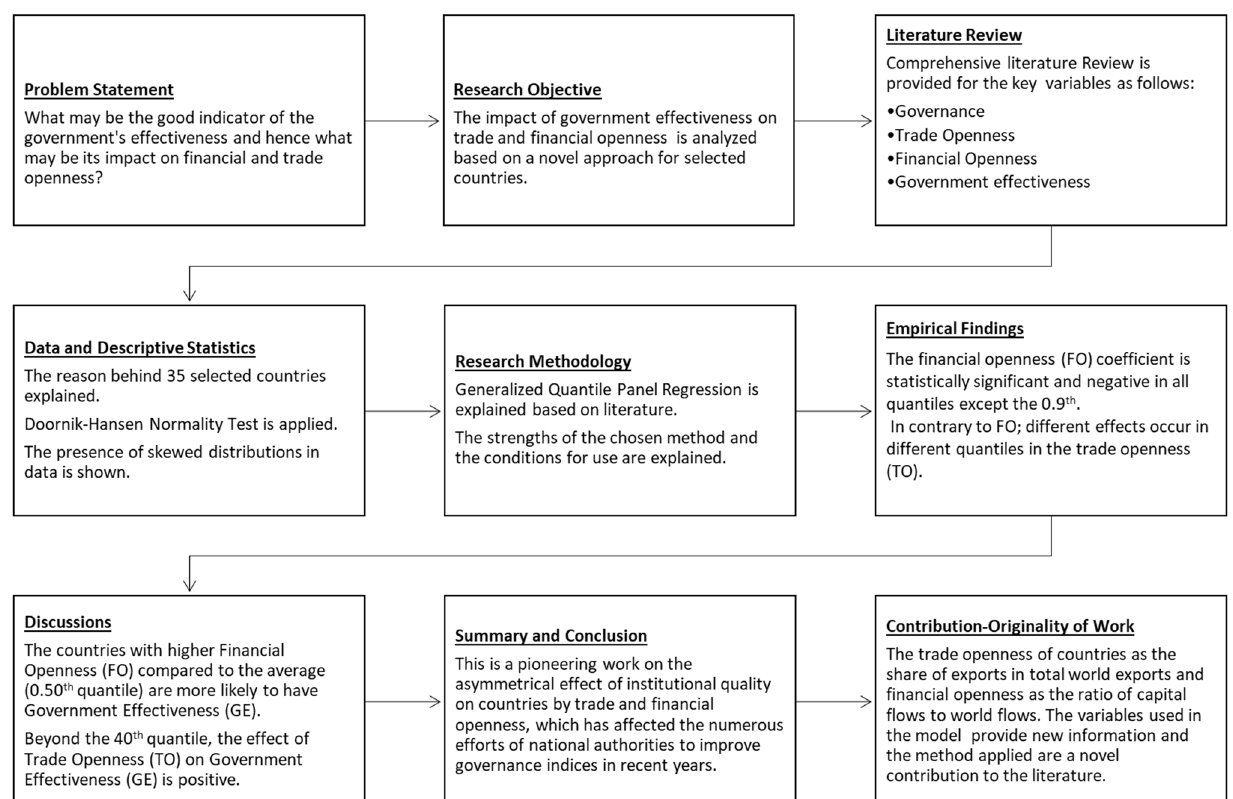
Figure 1. Work flow of research. Source: Prepared by the authors.